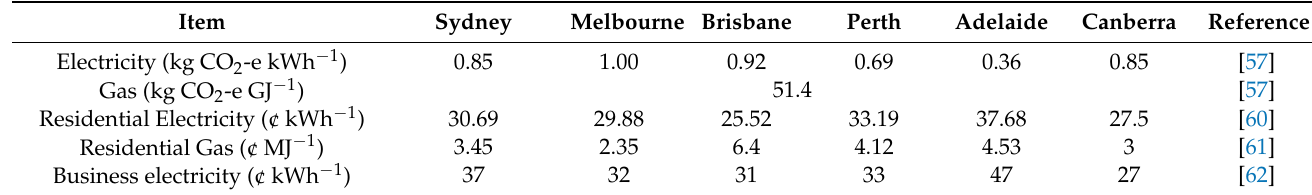
Table A3. GHGE factors and unit prices for electricity and gas.